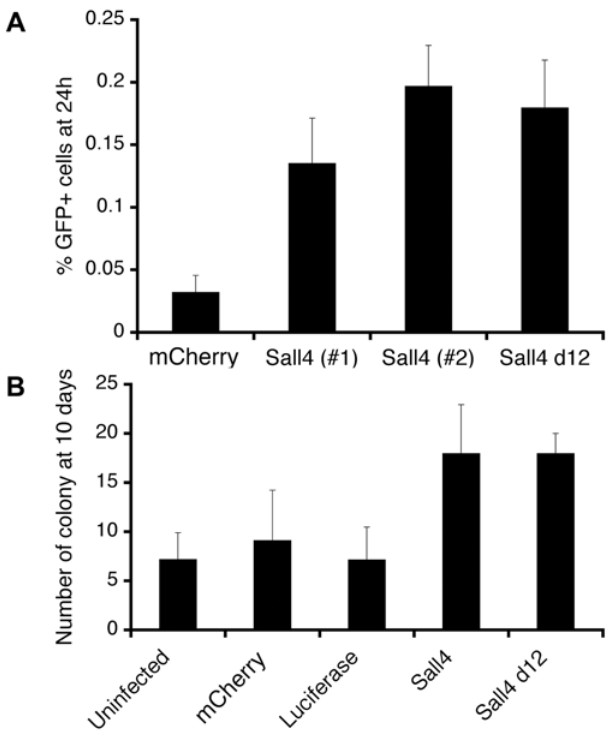
Figure 5. The N-terminal domain is not required for Sall4 function in reprogramming. A) Sall4 d12 mutant behaved similarly to wt Sall4 in reprogramming. Sall4 d12, as well as two clones of wt Sall4 of identical sequences, were overexpressed in Oct4-gfp MEFs, which were then fused to ESCs and assayed for GFP expression as described. B) The overexpression of Sall4 d12 resulted in a similar increase in the number of Oct4-gfp cells as wt Sall4, as well as a similar increase in the number of reprogrammed